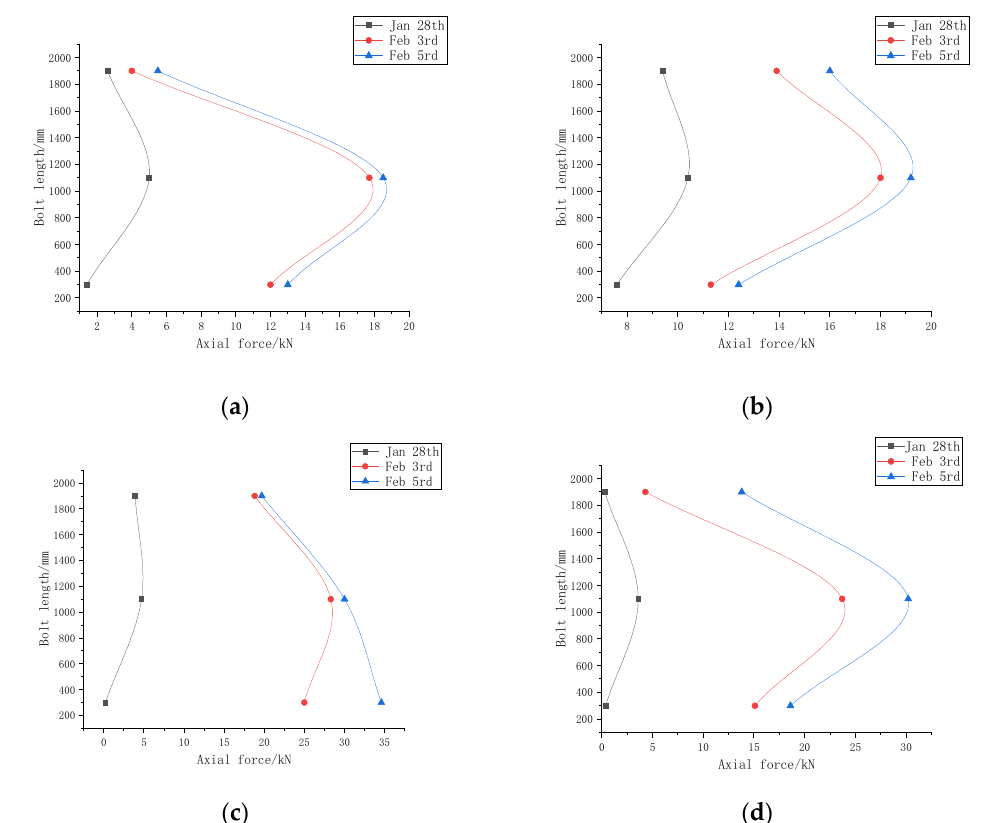
Figure 13. Distribution of the axial stress of the bolt along the body at two measuring points. ( a ) Axial stress distribution diagram of left bolt at No. 1 measuring point; ( b ) Axial stress distribution diagram of right bolt at No. 1 measuring point; ( c ) Axial stress distribution diagram of left bolt at No. 2 measuring point; ( d ) Axial stress distribution diagram of right bolt at No. 2 measuring point.